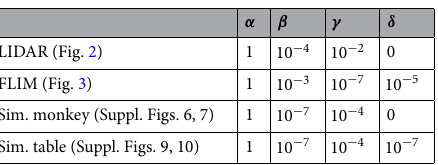
Table 1. Parameters used in the reconstruction of all images in the main text and Supplementary Information.